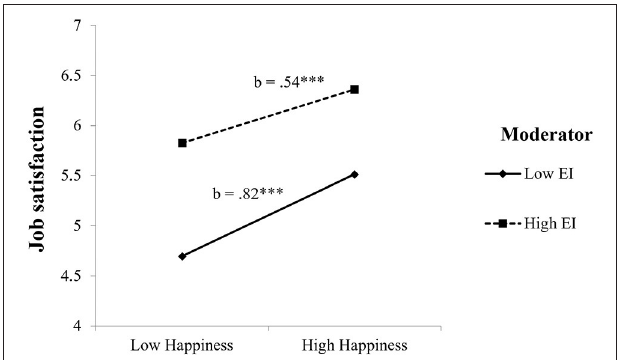
FIGURE 2 | Interaction between EI and happiness on job satisfaction. *** p < 0.001.